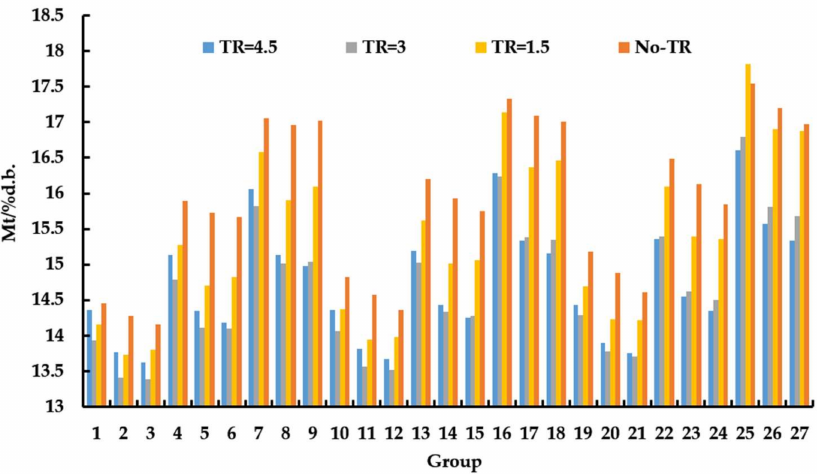
Figure 7. Comparison of moisture calculated by the two